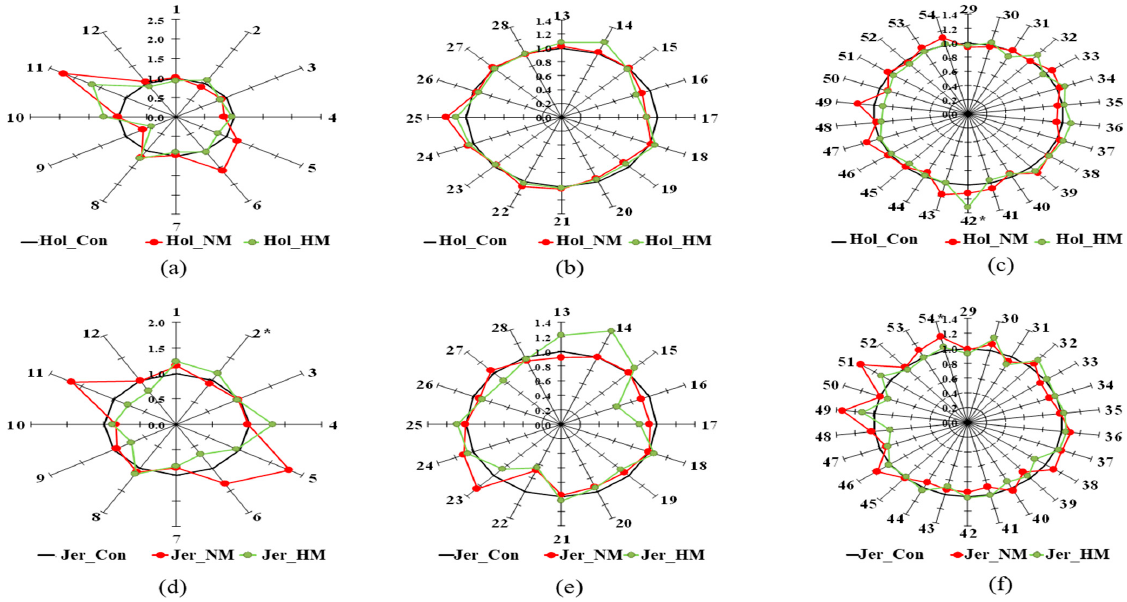
Figure 3. Star symbol plots of OAs ( a , d ), FAs ( b , e ), and AAs ( c , f ) in the sera of Holstein ( a – c ) and Jersey steers ( d – f ) supplemented with different concentrations of minerals. Hol, Holstein; Jer, Jersey; Con: only TMR (without mineral supplementation), NM: TMR + NRC recommended concentration of mineral supplementation (Se 0.1 ppm + Zn 30 ppm + Cu 10 ppm)/kg DM and HM: TMR + higher than recommended concentration of mineral supplementation (Se 3.5 ppm + Zn 350 ppm + Cu 28